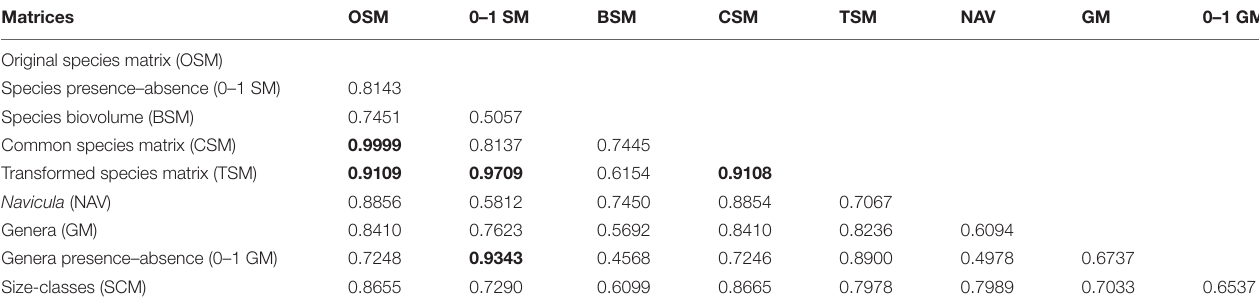
TABLE 2 | Pairwise Spearman’s rank correlation between similarity matrices.